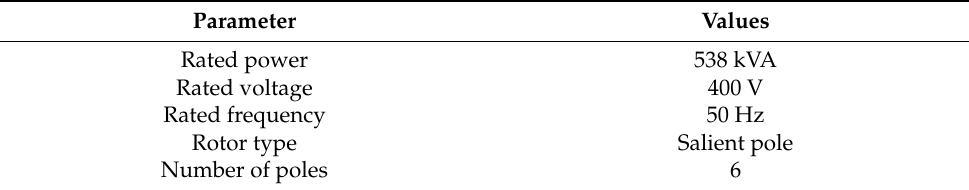
Table 1. Parameters of the studied machine. Parameter Values Rated power